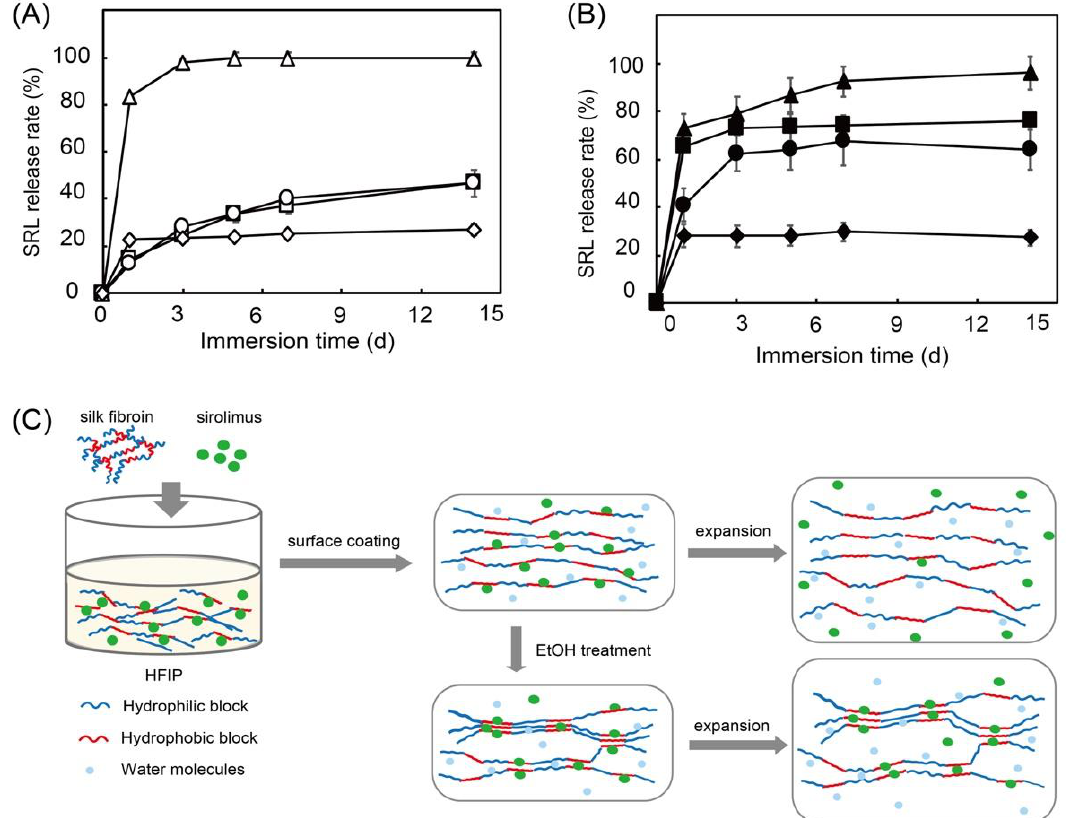
Figure 11. Sirolimus release over 14 days from silk fibroin (squares), silk fibroin with ethanol treatment (circles), poly-D,L-lactic acid (diamonds), and poly-caprolactone (triangles) on Co-Cr stents before ( A ) and after ( B ) balloon expansion in 37 °C phosphate buffered saline. Hypothesized mechanism of sirolimus release from silk-fibroin-coated stents before and after balloon expansion ( C ). Adapted with permission from [82]; published by American Chemical Society, 2020.